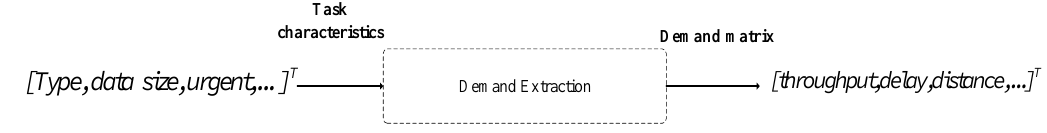
Figure 7. Network requirements extraction process.